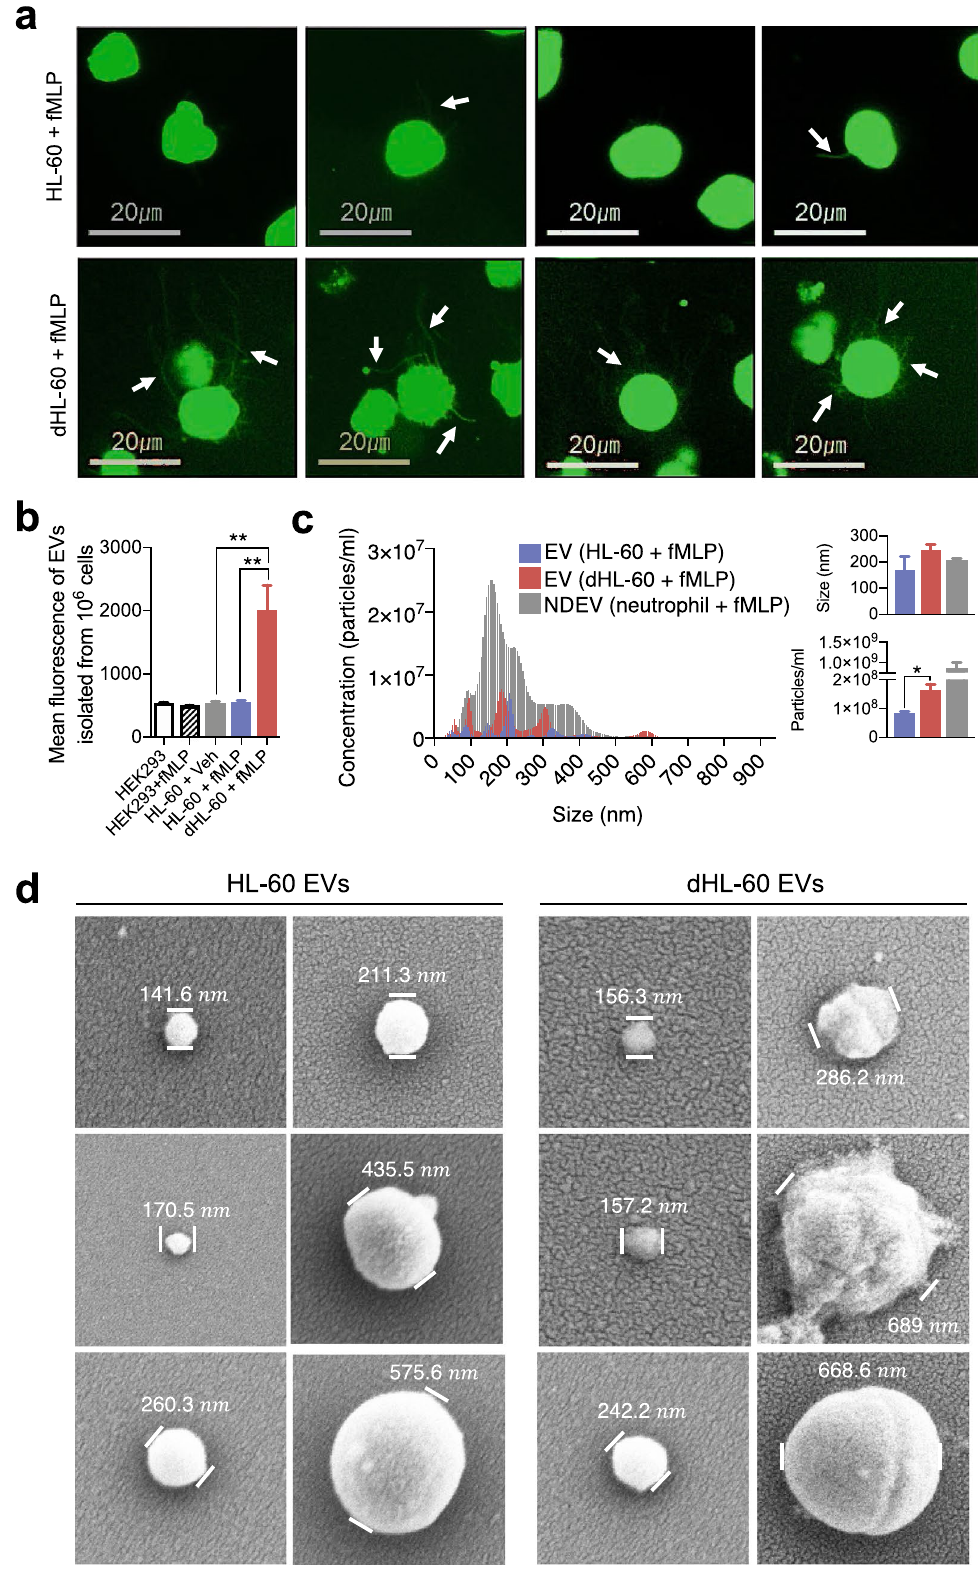
Figure 1. The naïve HL-60 cells and dHL-60 cells release a heterogeneous population of EVs. ( a ) Representative images showing EVs released from HL-60 cells and dHL-60 cells stimulated with fMLP. The arrow indicates membrane protrusions during EVs release. ( b ) Quantification of relative amounts of EVs derived from the naïve HL-60 and dHL-60 cells pre-stained with calcein-AM in the presence or absence of fMLP stimulation. ( c ) A representative plot showing the size and concentration of EVs derived from the HL-60 cells, dHL-60 cells, and neutrophils stimulated with fMLP. ( d ) Scanning electron microscopic analysis of EVs generated from HL-60 and dHL-60 cells. The data shown are the mean ± SEM. *P < 0.05; **P <